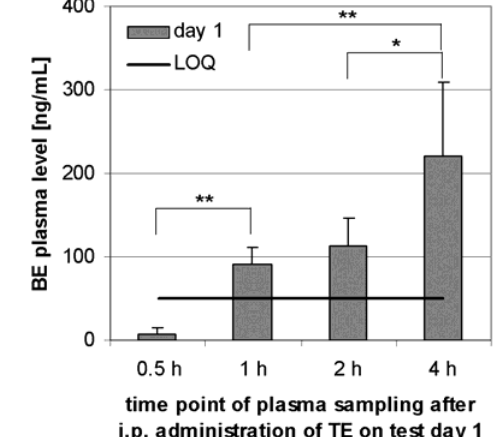
Figure 4 . Plasma BE levels after i.p. administration to 18 Sprague-Dawley rats (9 males, 9 females). Samples were taken at the specified time after administration on test day 1. Error bars: